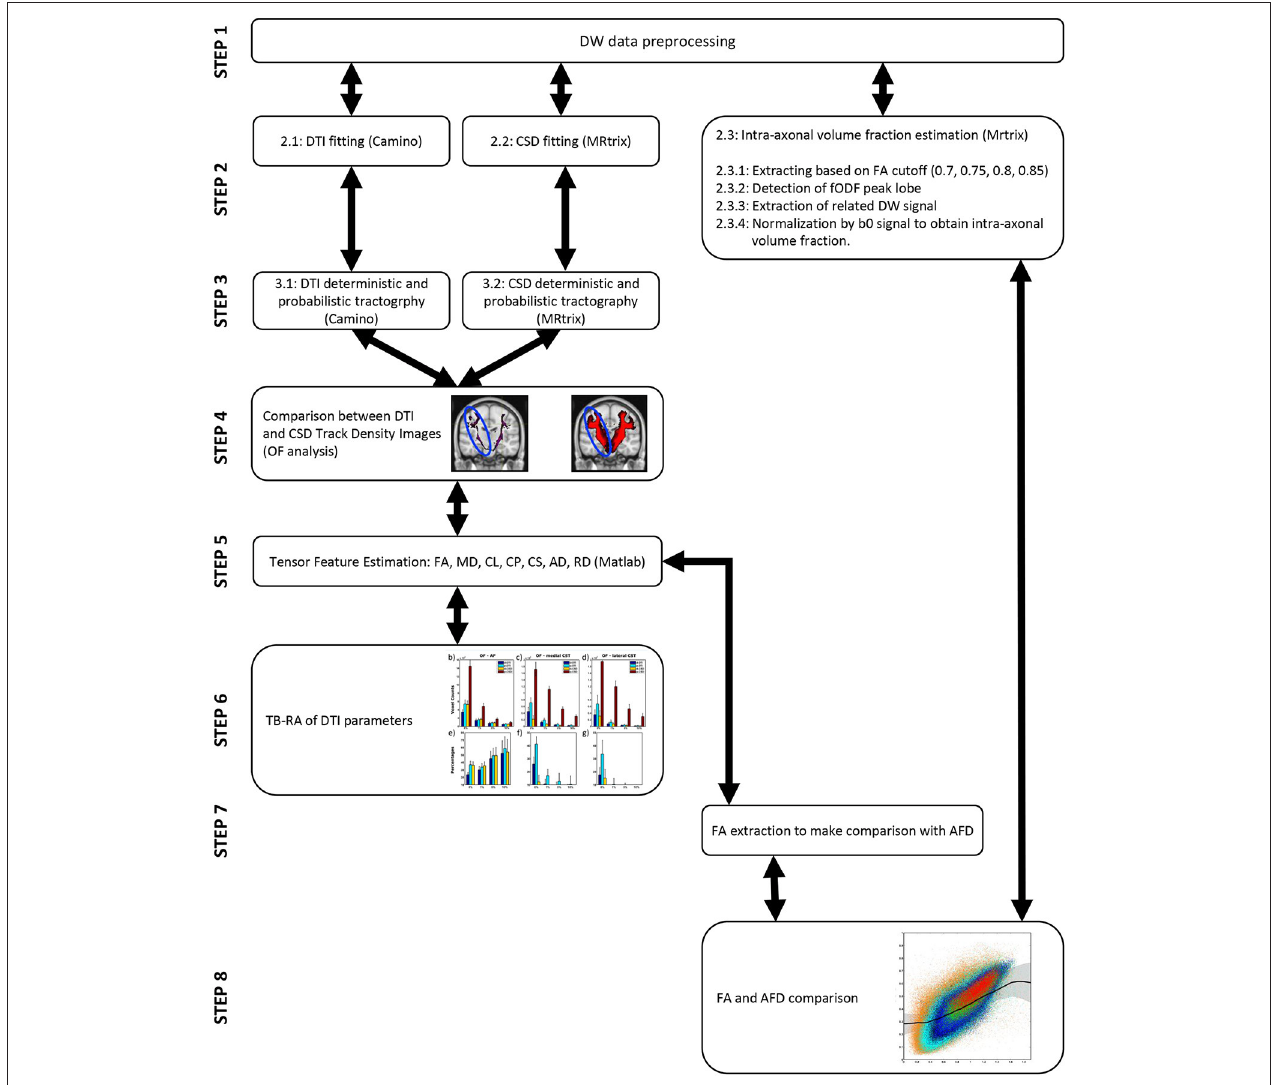
FIGURE 5 | Pipeline of all the experiments conducted. On the left steps leading to tractographic reconstruction comparisons and TB-RA (steps 2–6) are reported. On the right steps leading to AFD analysis (steps 2, 7, 8) are instead